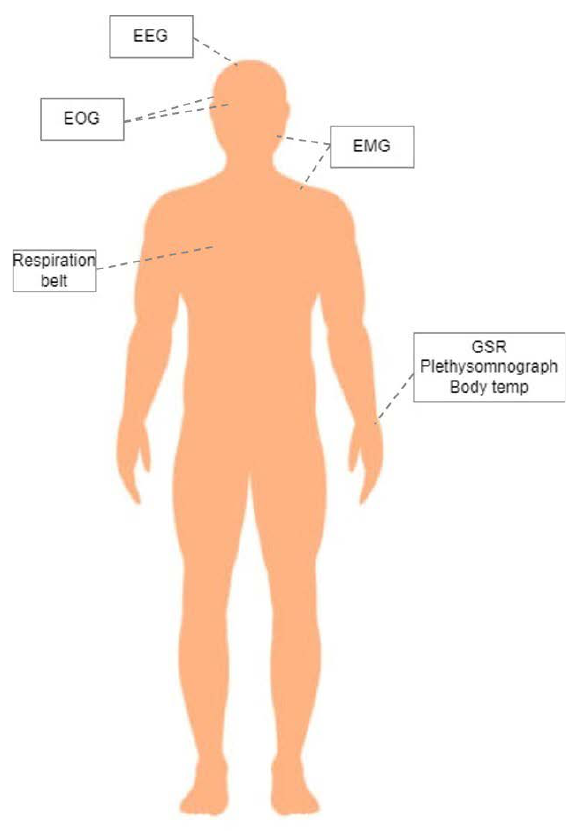
Figure 1. Schematic representation of the deployed sensors in the DEAP dataset and their place on the human